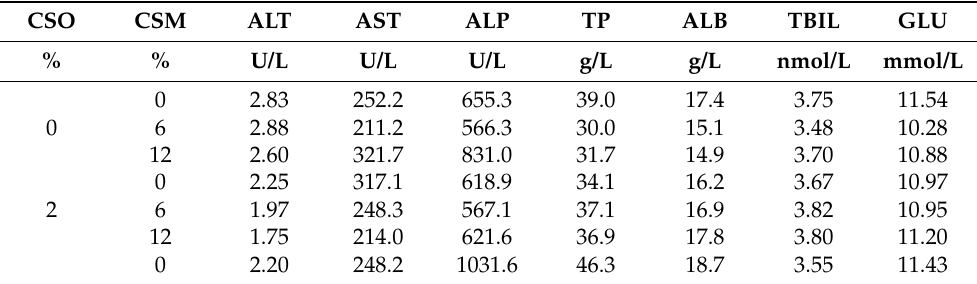
Table 7. Effects of cottonseed oil (CSO) and cottonseed meal (CSM) on serum biochemical parameters in laying hens 1